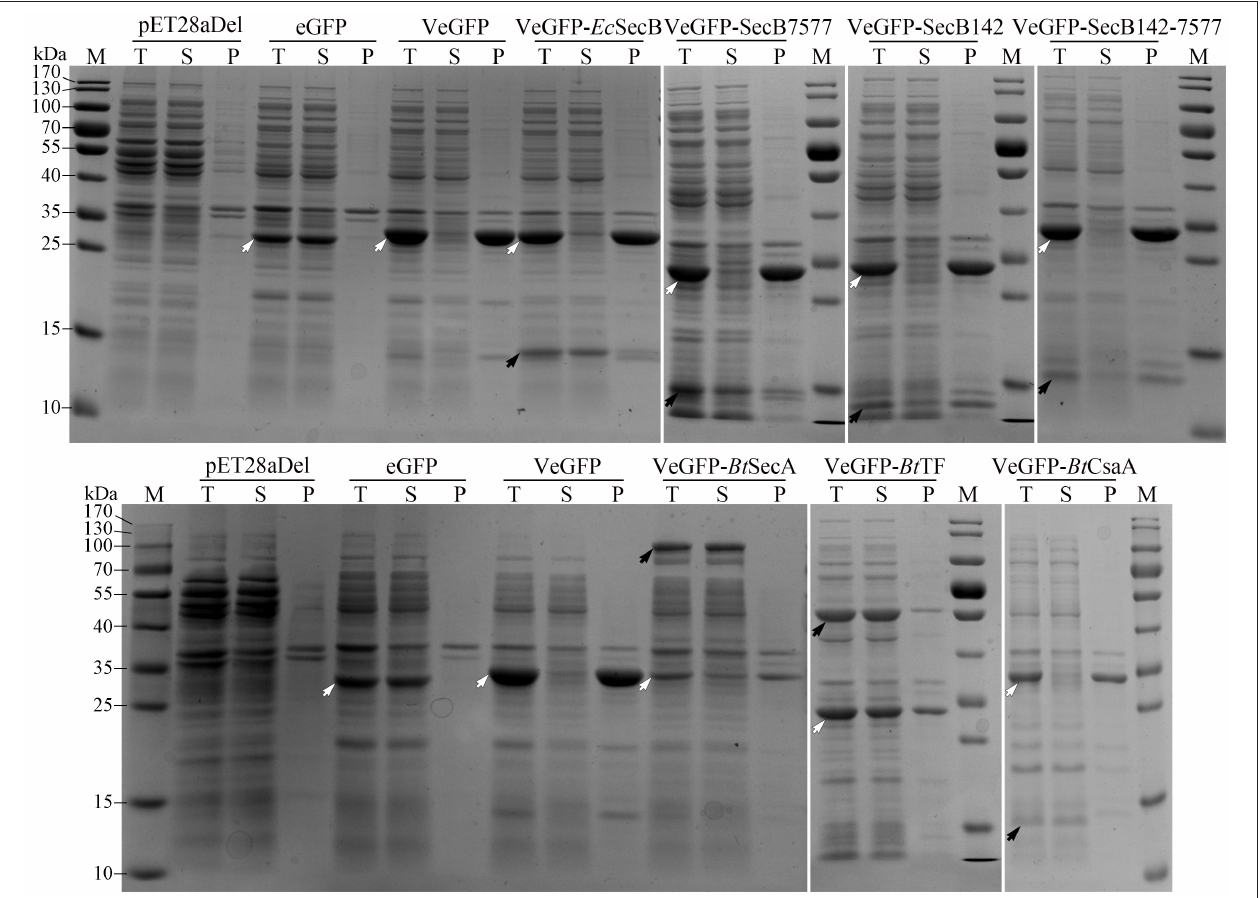
FIGURE 4 | Coexpression analysis of VeGFP with several chaperones. For each sample, the total proteins (T), the soluble component after cell lysis (S), and the precipitates (P) were loaded, respectively. The black arrows indicate the corresponding chaperones ( Ec SecB, 17.3 kDa; SecB7577, 17.3 kDa; SecB142, 15.9 kDa; SecB142-7577, 15.9 kDa; Bt CsaA, 11.9 kDa; Bt SecA, 95.0 kDa; Bt TF, 47.3 kDa). The hollowed arrows indicate the target recombinant